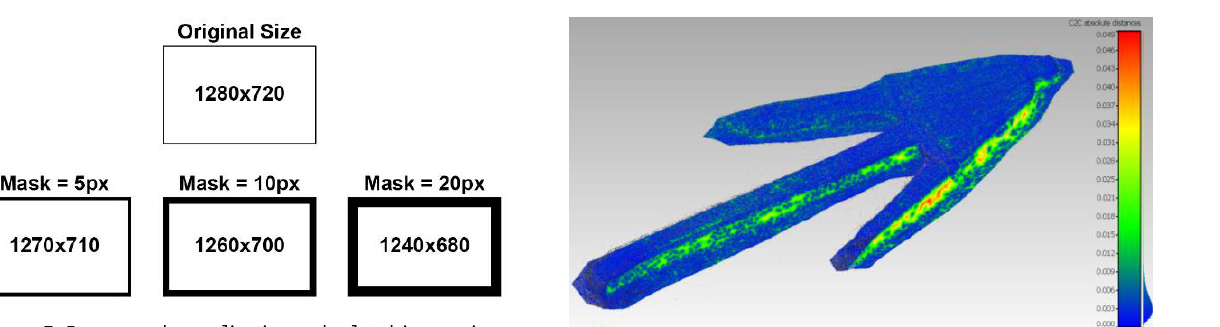
Figure 7. Image masks application and related image size reduction